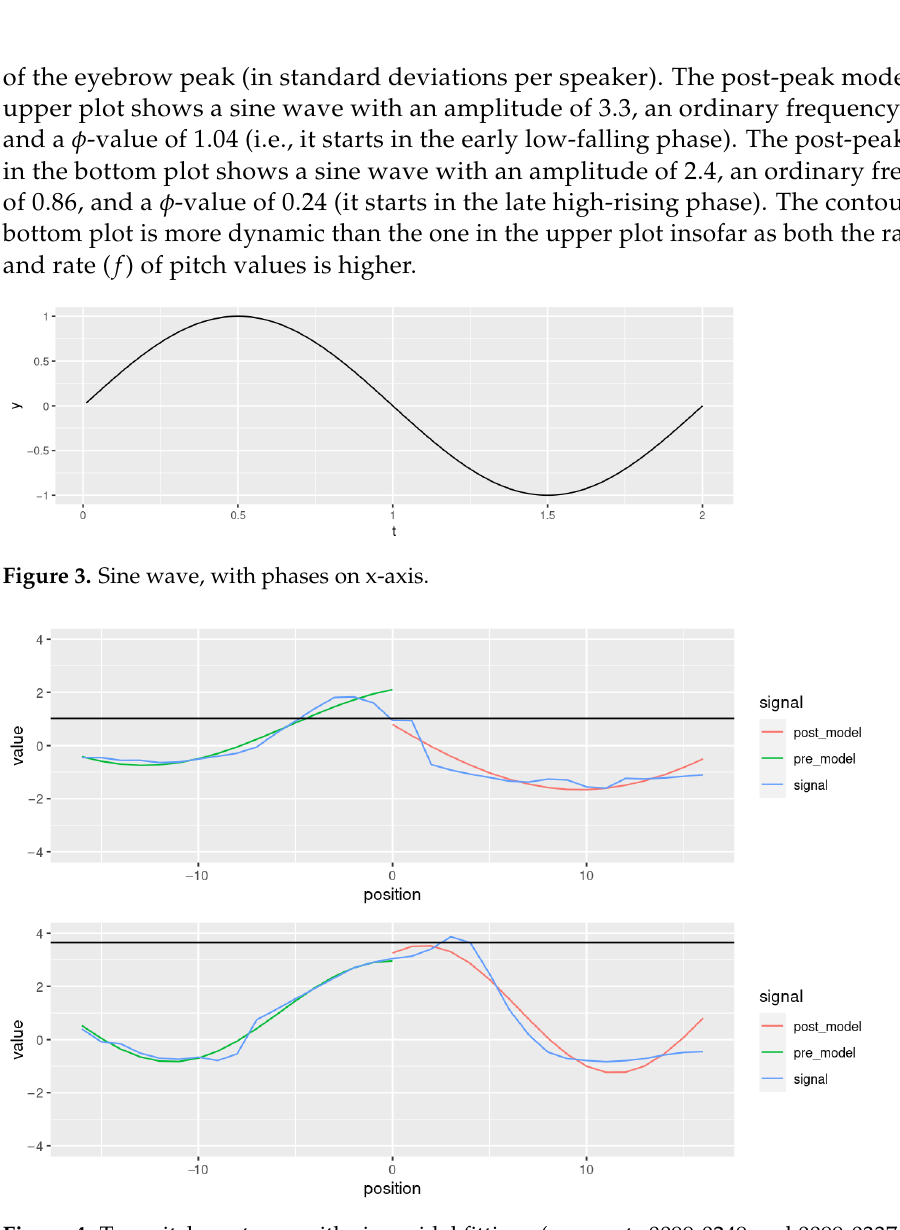
Figure 4. Two pitch contours with sinusoidal fittings (segments 0099-0249 and 0099-0337, both by QC). The blue line shows the pitch contour, the green line shows the sine curve fitted to the pre-peak region, and the red line shows the sine curve fitted to the post-peak